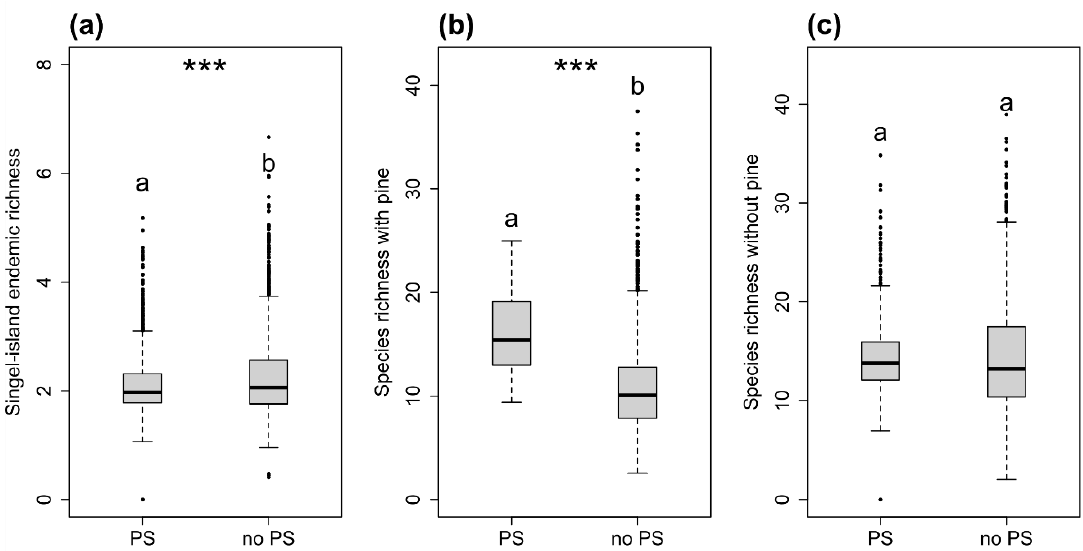
Figure 6. ( a ) Single island endemic plant species richness in projected suitable and unsuitable habitat for P. setaceum . ( b ) Total species richness in areas suitable and unsuitable for P. setaceum. ( c ) Species richness of unsuitable compared to suitable habitat excluding the Pinus canariensis forest. Highly significant results are indicated by three asterisks.